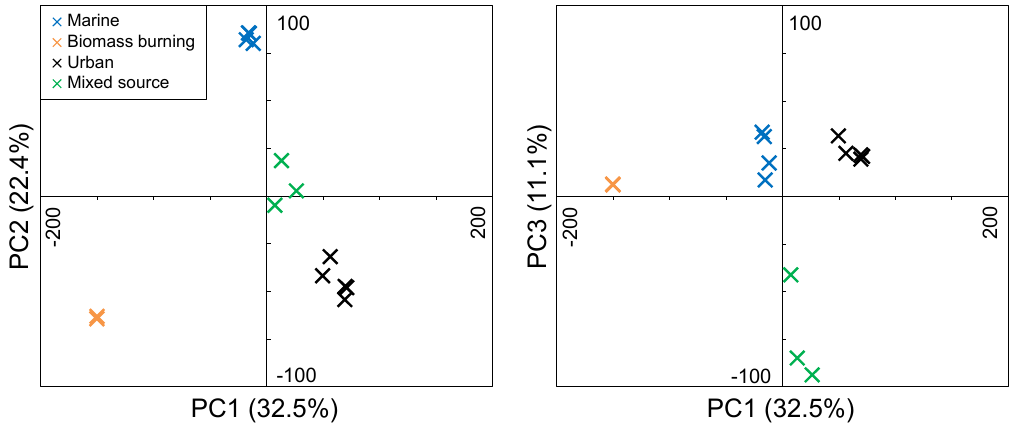
Figure 2. PCA score plots for PC2 versus PC1 ( left ) and PC3 versus PC1 ( right ). PCA was performed using molecular formulas identified in FTICR mass spectra for aerosol OM extracts from marine, biomass burning, urban, and mixed source areas.